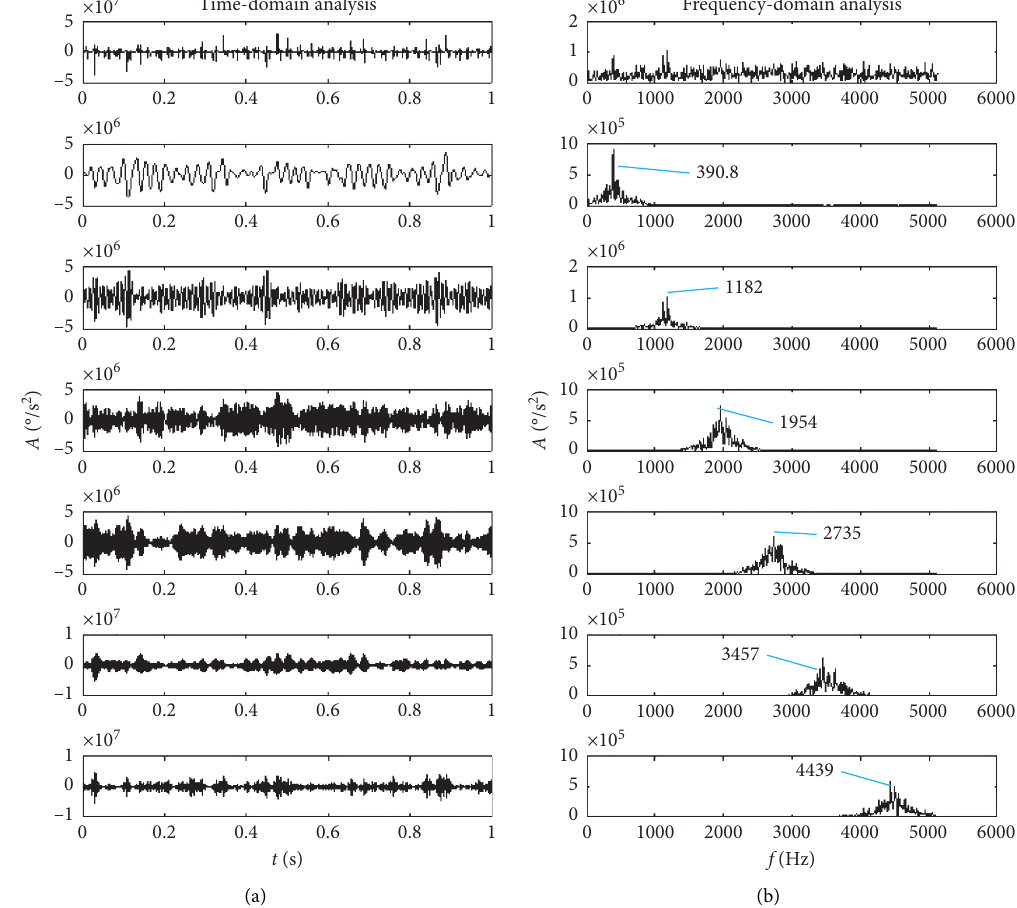
Figure 10: Each IMF of angular acceleration signal for 3 # crack. (a) Time-domain waveform. (b) Frequency-domain